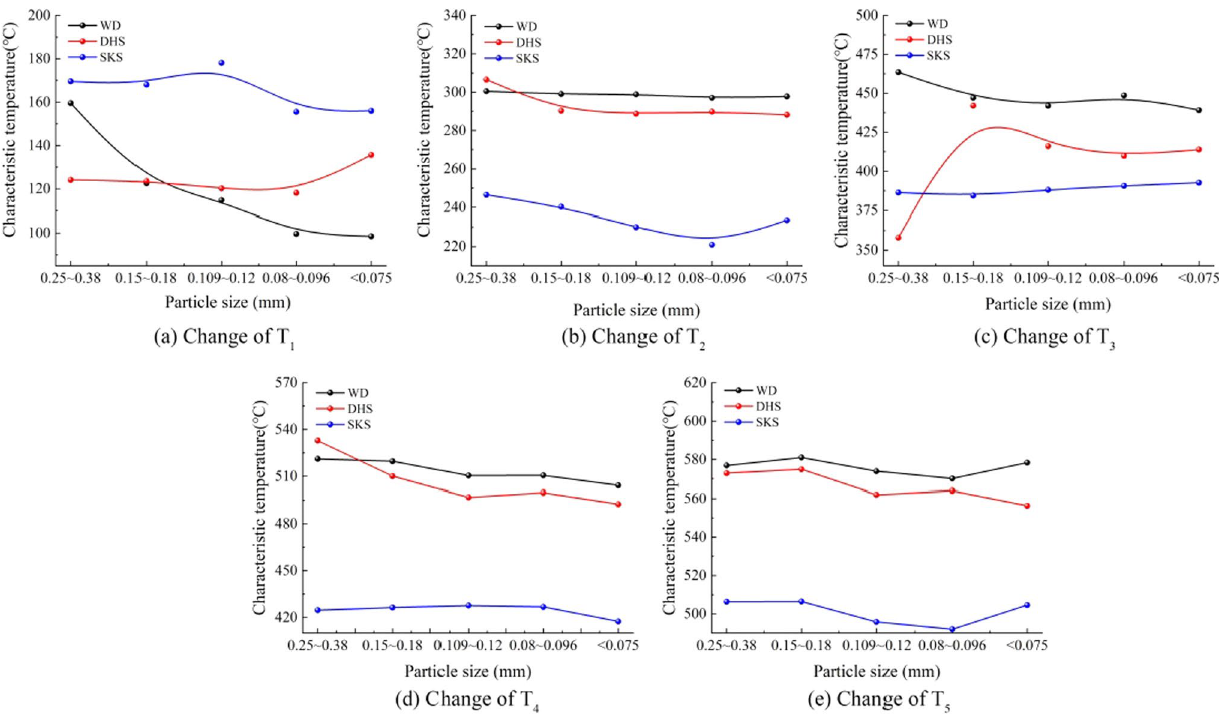
Fig. 10 Characteristic temperatures of coal samples as a function of particle sizes